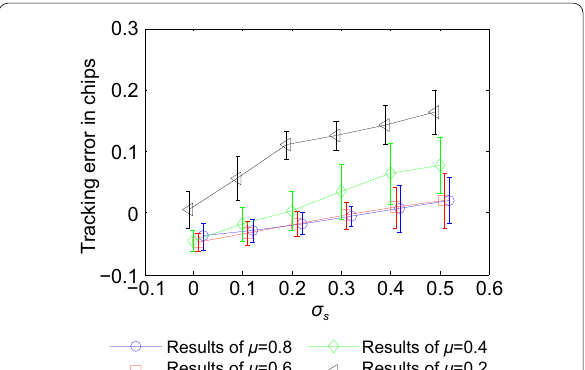
Fig. 5 Influence of the amplitude of the NLOS signal on the tracking